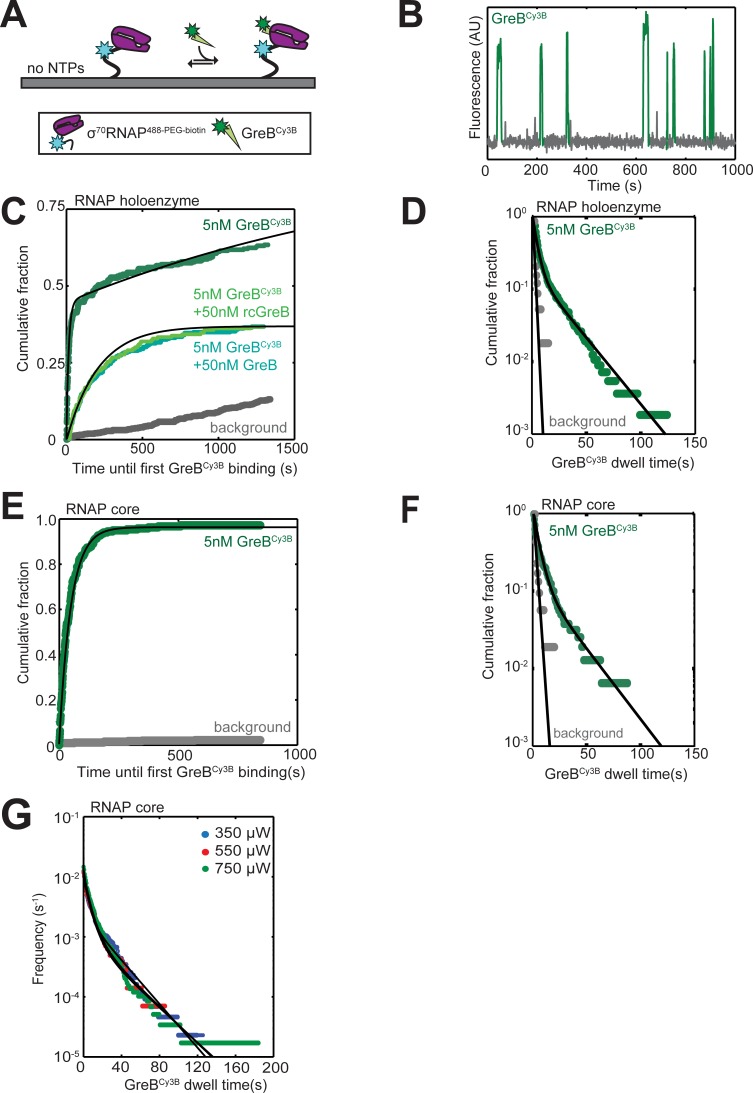
Kinetics of GreB binding to and dissociation from RNAP and σ70RNAP.(A) Experimental scheme for single-molecule measurement of the kinetics of GreB binding to and dissociation from surface-tethered σ70RNAP. σ70RNAP488-PEG-biotin was tethered to the slide surface via a neutravidin linkage and the co-localization of GreBCy3B (5 nM, 93% labeled) was monitored. (B) Example GreBCy3B intensity record from the location of a single σ70RNAP488-PEG-biotin molecule. An objective image analysis algorithm (see Materials and methods) detected a spot of GreBCy3B fluorescence at the times shown in green. (C) Cumulative distribution of the time until the first GreBCy3B appearance at the location of each σ70RNAP488-PEG-biotin molecule (dark green). Exponential fit (black) is corrected for non-specific binding of GreBCy3B to the chamber surface measured at control locations where no σ70RNAP488-PEG-biotin was detected (gray), yielding kon = 1.5 ± 0.9×107 M−1 s−1. Also shown are data from experiments with added 50 nM GreB or rcGreB (light green curves) demonstrating that either species effectively competed with 5 nM GreBCy3B, indicating that GreBCy3B binding is specific. The curve shown (black) is the predicted cumulative distribution of times until the first GreBCy3B binding event at 50 nM GreB or rcGreB based on a competition model which assumes that GreB and rcGreB exhibit the same kinetics of binding to and release from σ70RNAP488-PEG-biotin as GreBCy3B (i.e., the same kon, Af, and τ1 reported in Table 1). (D) Cumulative distribution of GreBCy3B dwell times on surface-tethered σ70RNAP488-PEG-biotin molecules. Data (green) were fit to a biexponential model (black) with the parameters listed in Table 1. (E and F) Same as (C) and (D), but with core RNAP488-PEG-biotin instead of holoenzyme. Fit parameters and numbers of observations distributions in C-F are given in Table 1. (G) GreBCy3B photobleaching control. Cumulative frequency distribution (Friedman and Gelles, 2015) of GreBCy3Bdwell times on surface-tethered RNAP core measured as in (F) but at different 532 nm laser excitation powers. Data show no evidence for shorter lifetimes at higher power, suggesting that there is no appreciable photobleaching under the conditions of the experiments.